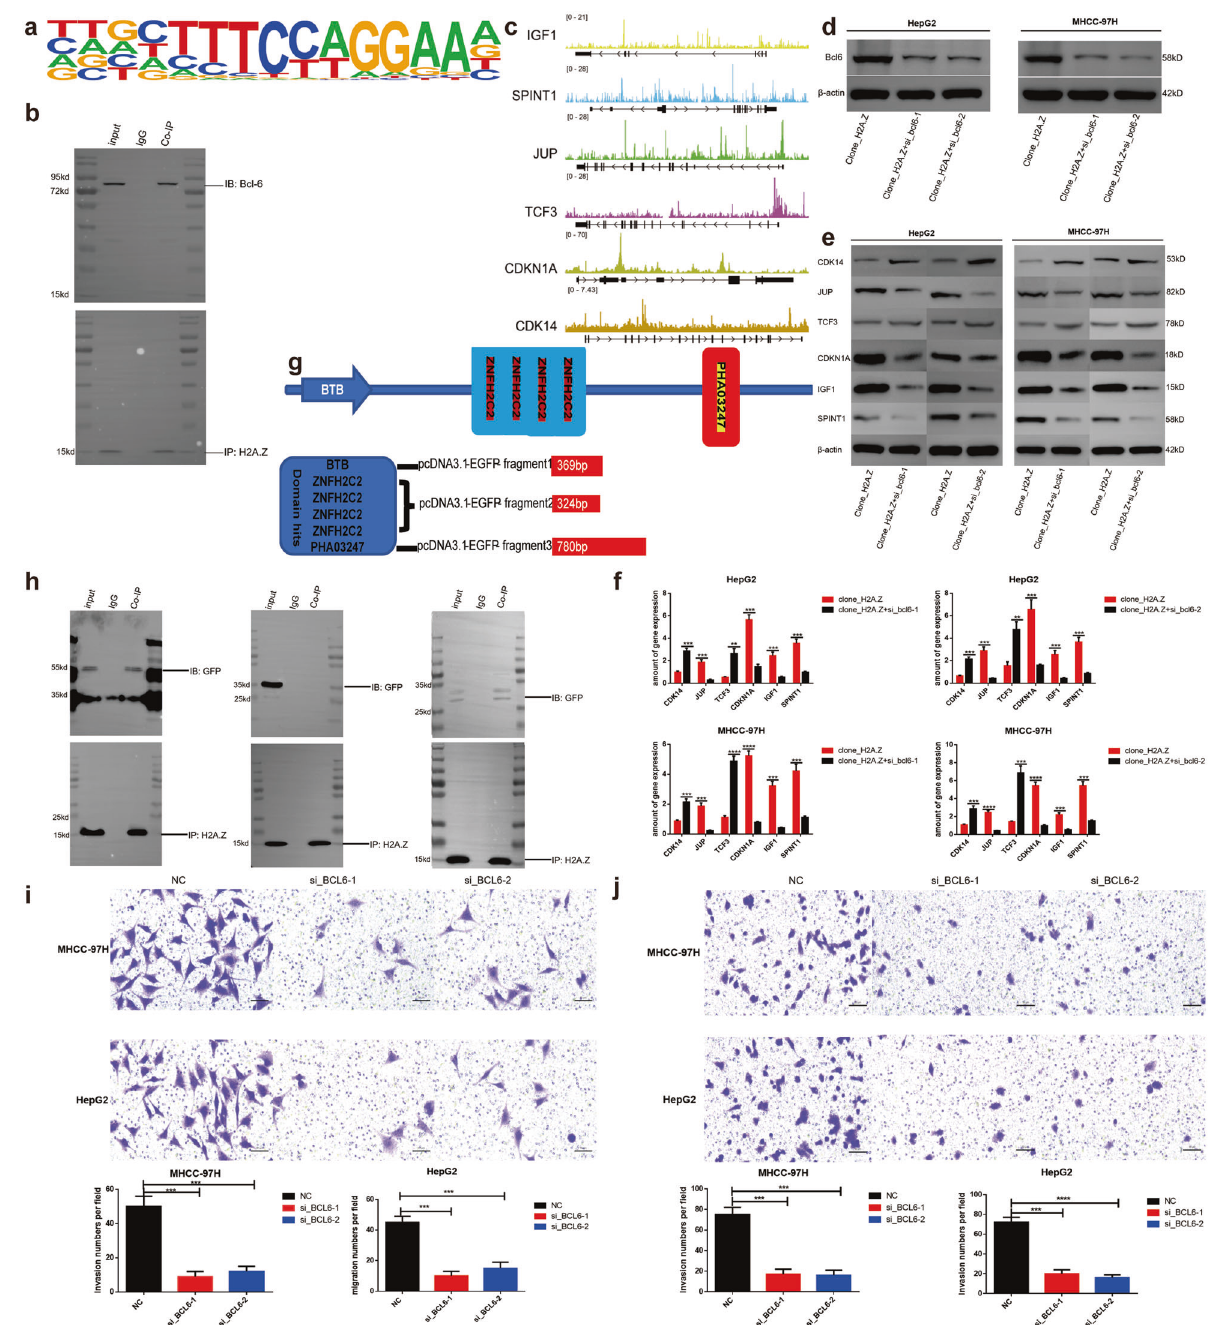
Fig. 4 BCL6 is the main interaction protein of H2A.Z in HCC, and the protein domains binding to H2A.Z are BTB and PHA03247. a Motif analysis of H2A.Z and BCL6 in chip-seq of H2A.Z. b Co-IP analysis of H2A.Z and BCL6 in HepG2 cell. c IGV diagram of the downstream target gene of H2A.Z in the combined analysis data of H2A.Z RNA-seq and BCL6 chip-seq. d Validation of BCL6 gene knockout effect detected by western blot. e , f QRT-PCR, and western blot veri fi ed the changes of downstream target genes after BCL6 knockdown in H2A.Z overexpressed HCC cell lines. g Schematic diagram of the BCL6 protein domain(https://www.uniprot.org/). h The interaction of BCL6 protein regions with H2A.Z in HEK293T cells was con fi rmed by a Co-IP assay, which showed the protein domains binding to H2A.Z are BTB and PHA03247. i , j Transwell assay was adopted to test cell migration and invasion under different contexts. The data are expressed in terms of mean ± SD (Student ’ s t -test used in Fig h , i and j ; ** P < 0.01; *** P < 0.001; **** P < 0.0001; n = 3 in each modi fi cation of histones [20 – 23]. Whether lincRNA is involved in LincZNF337-AS1 bound to H2A.Z and H2A.Zac regulated the the acetylation of H2A.Z was considered worth exploring. There- acetylation of H2A.Z and affected the transcription of fore, we performed a RIP experiment with acetylated H2A.Z downstream target genes protein and sequenced the lincRNA data associated with it (GEO: With the development of lincRNA research, increasing evidence PRJNA668278). Since there was no antibody to cover all the has shown lincRNA to play an important role in post- acetylation sites on H2A.Z, we chose an antibody from Abcam (No. transcriptional modi fi cation of proteins, in particular, epigenetic